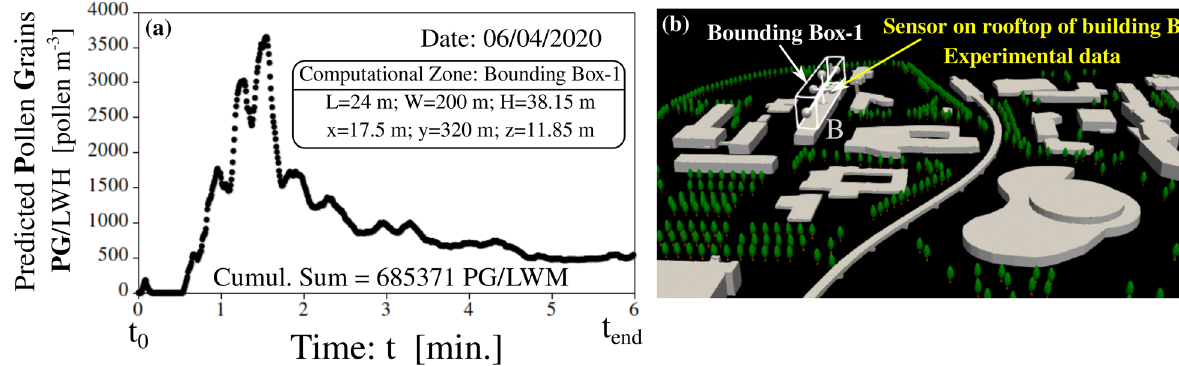
Figure 7. Numerically predicted pollen grains count over 6 minutes on the University campus in Lille-France. Numerical predictions of pollen grains (PG) as a function of time ( a ); computed for grains passed through a numerical acquisition Box-1 that mimics the experimental sensor located on the rooftop of building B ( b ). The dimensions of the Box-1 are L = 200 m ; W = 24 m ; H = 38.15 m , where L denotes the length, W is the width, and H is the height of this